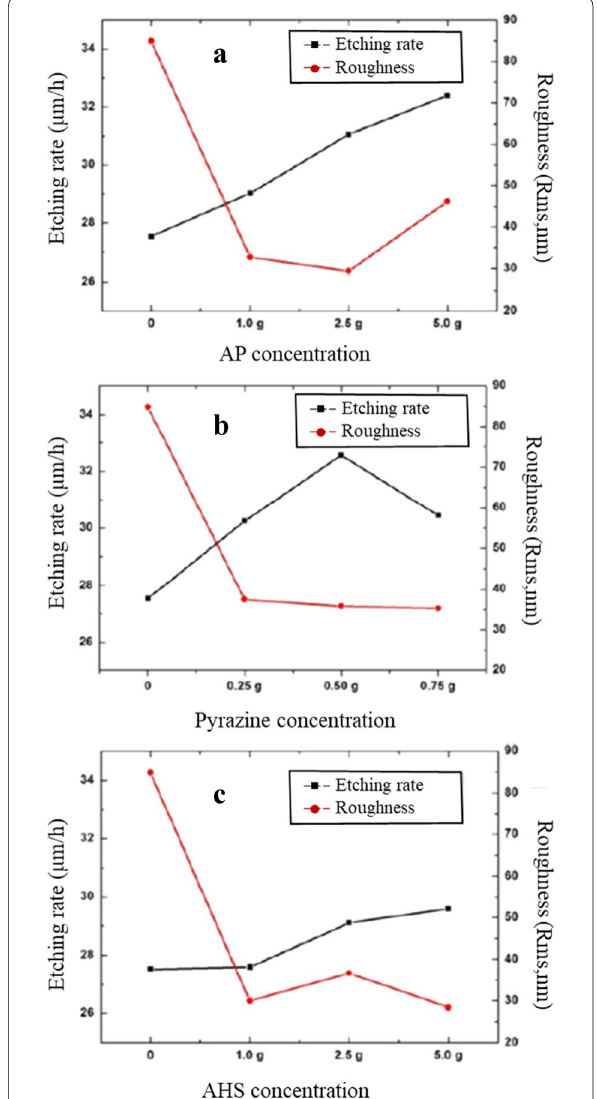
Fig. 27 Etch rate and surface roughness of Si{100} without and with addition of different amount of a ammonium persulfate (AP), b pyrazine, and c ammonium hydrogen sulfate (AHS) in per 500 mL 10 wt% TMAH at 70 °C [109], © 2015,